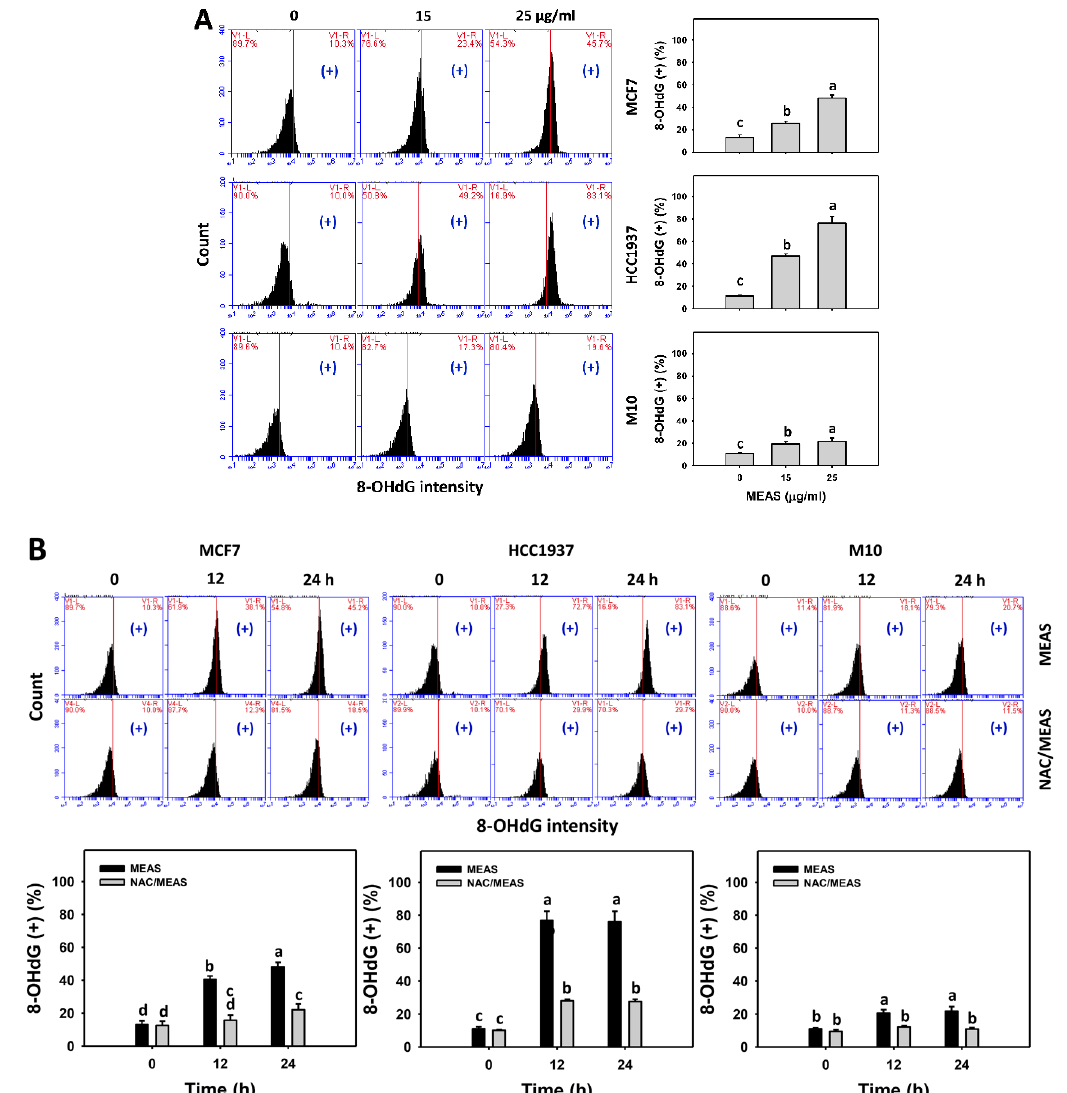
Figure 10. MEAS increased the 8-OHdG intensity of breast cancer cells. ( A ) 8-OHdG assay of MEAS. Except for normal breast cells (M10), others were TNBC and non-TNBC cells. Flow cytometry was performed after 24 h drug treatment. (+), inserted within each panel, indicates the 8-OHdG (+) intensity. ( B ) 8-OHdG assay of NAC/MEAS. NAC/MEAS represents NAC pretreatment (10 mM, 1 h) and MEAS posttreatment for 0, 12, and 24 h. Data = mean ± SD ( n = 3). Statistical software assigned low-case letters to each treatment.